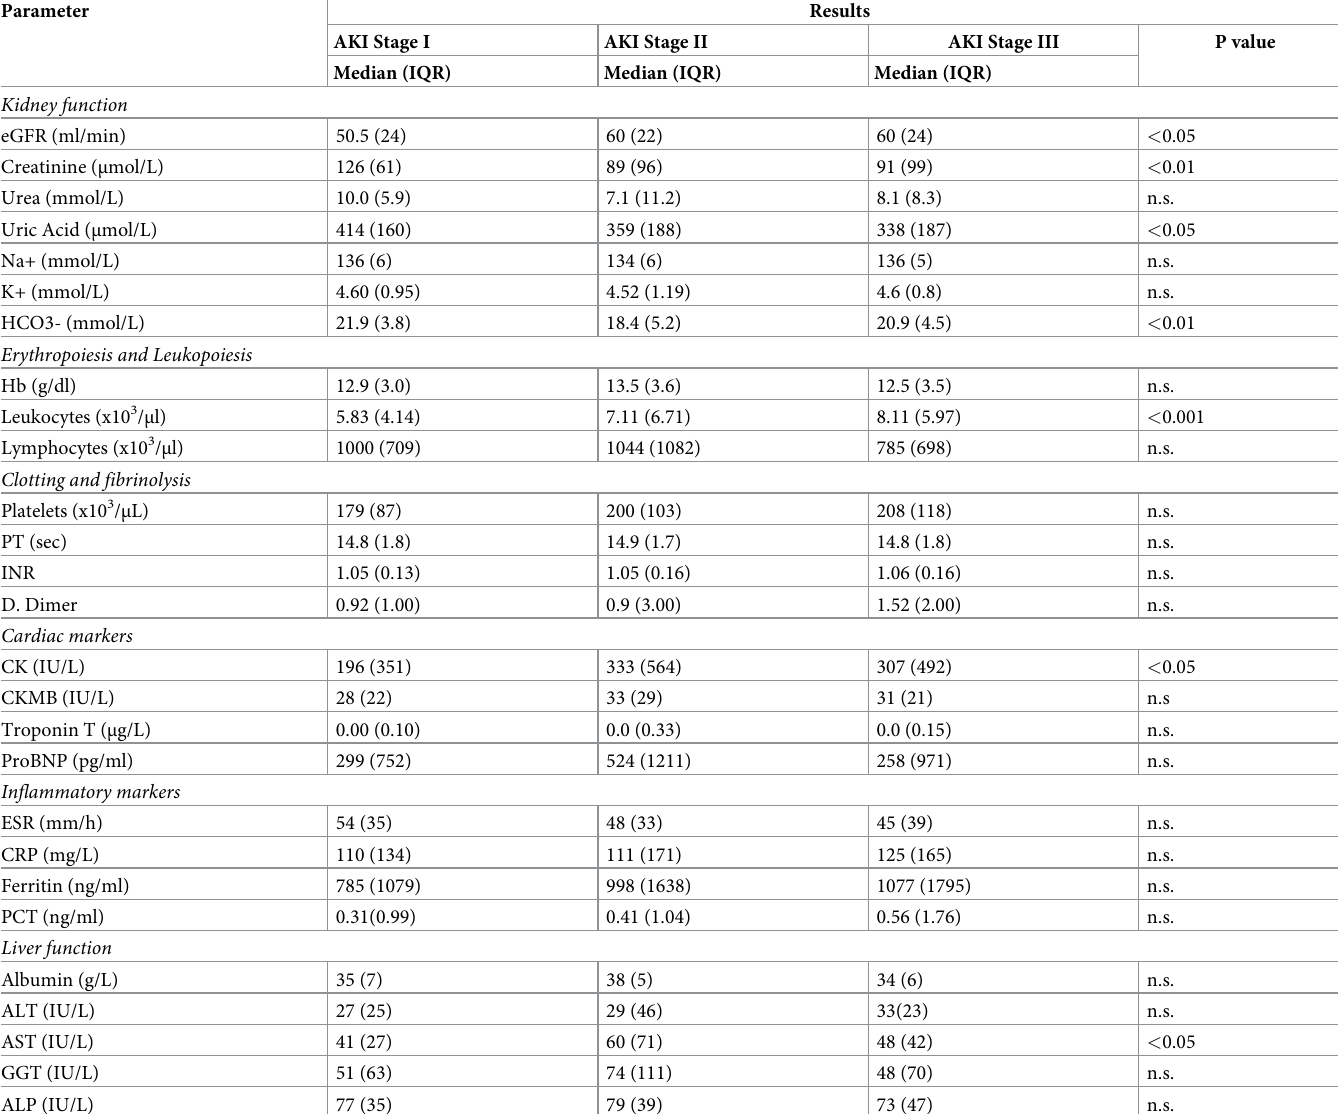
Table 3. Laboratory data at the time of admission of the COVID-19 patients that developed different AKI stages. Parameter